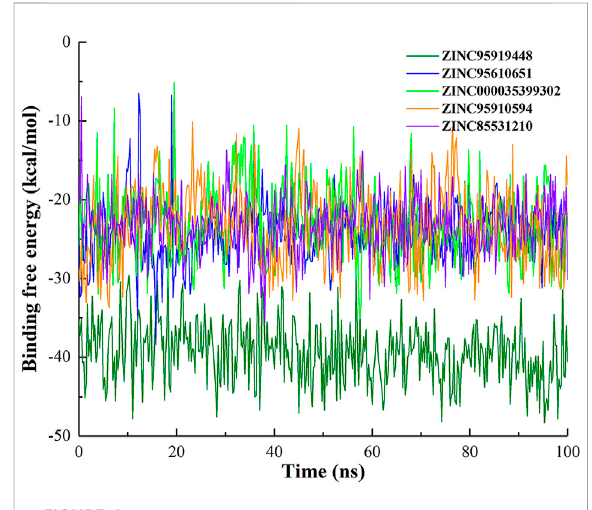
FIGURE 4 Binding free energy ( Δ Gbind) over time of top 5